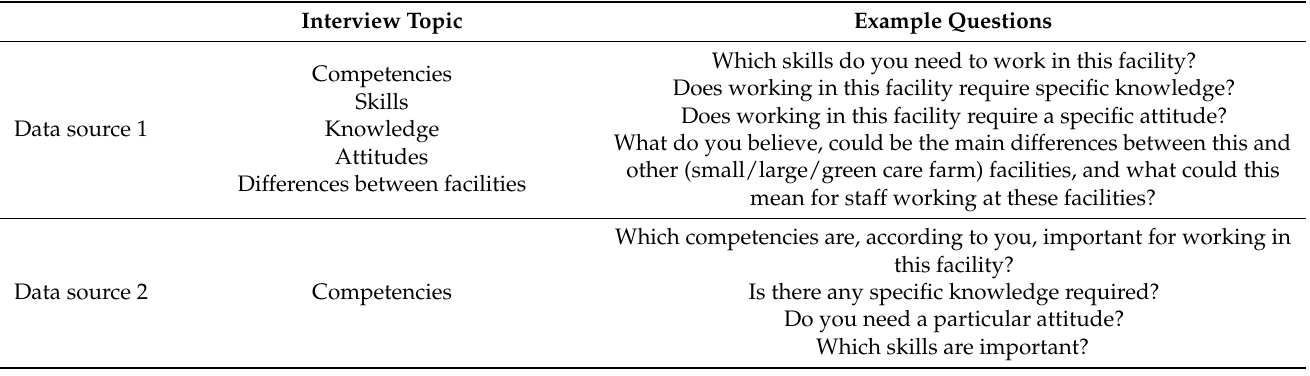
Table 2. Interview overview.